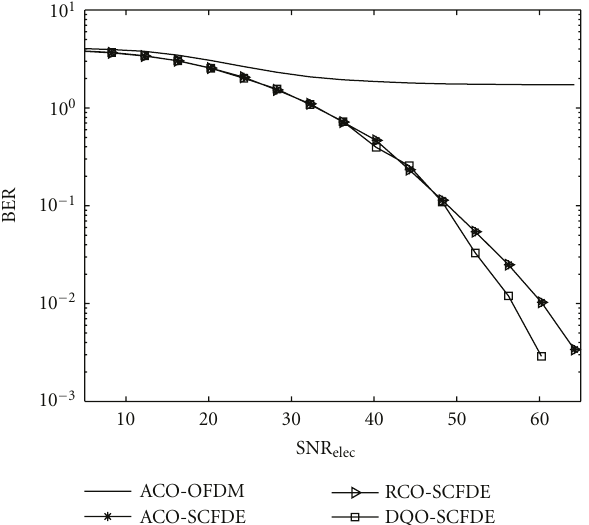
Figure 16: MMSE BER comparison of ACO-OFDM, ACO-SCFDE, RCO-SCFDE, and DQO-SCFDE with N = 64, 64 QAM input symbols with power 0.01 W, L = 3.